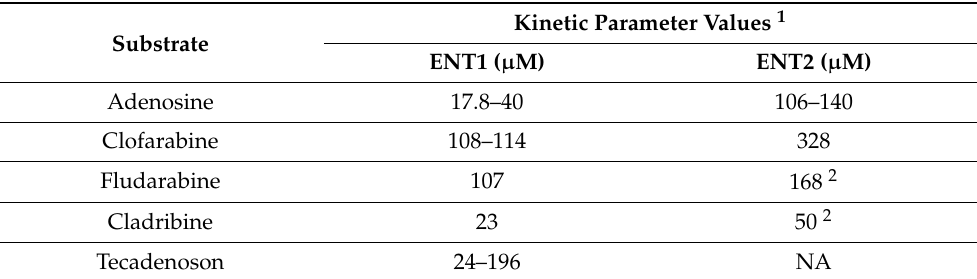
Table 2. Kinetic parameter values for cellular influx of adenosine and analogs of adenosine mediated by human recombinant equilibrative transporters 1 and